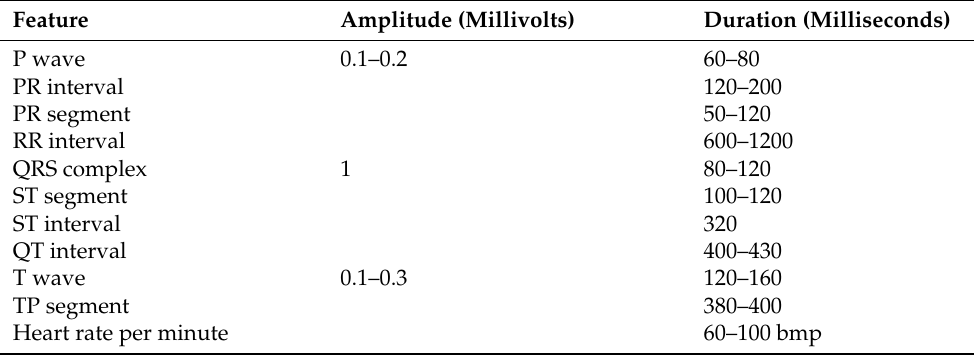
Table 1. Normal values of waves and intervals of ECG signal